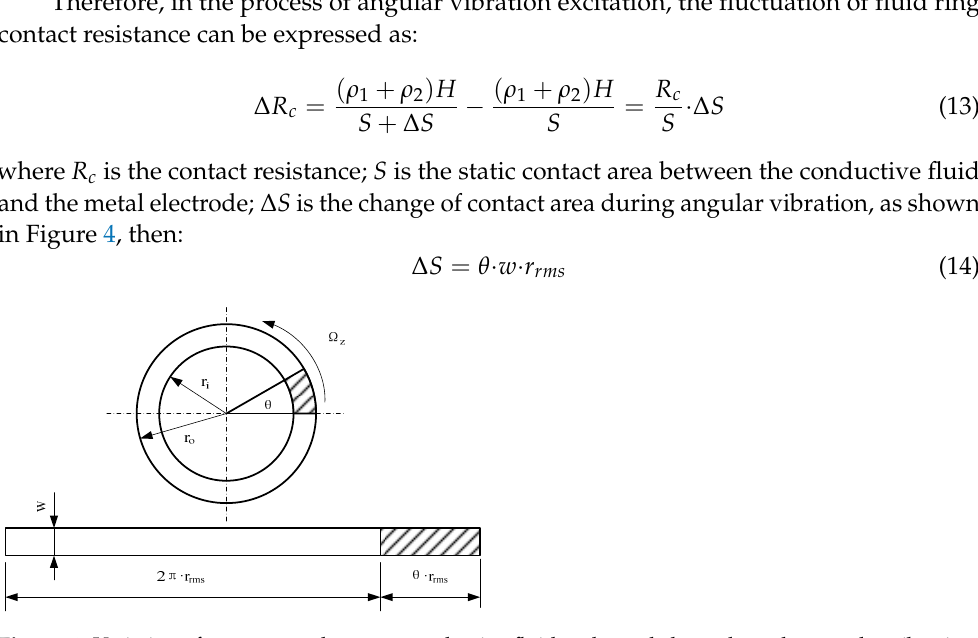
Figure 4. Variation of contact area between conductive fluid and metal electrode under angular